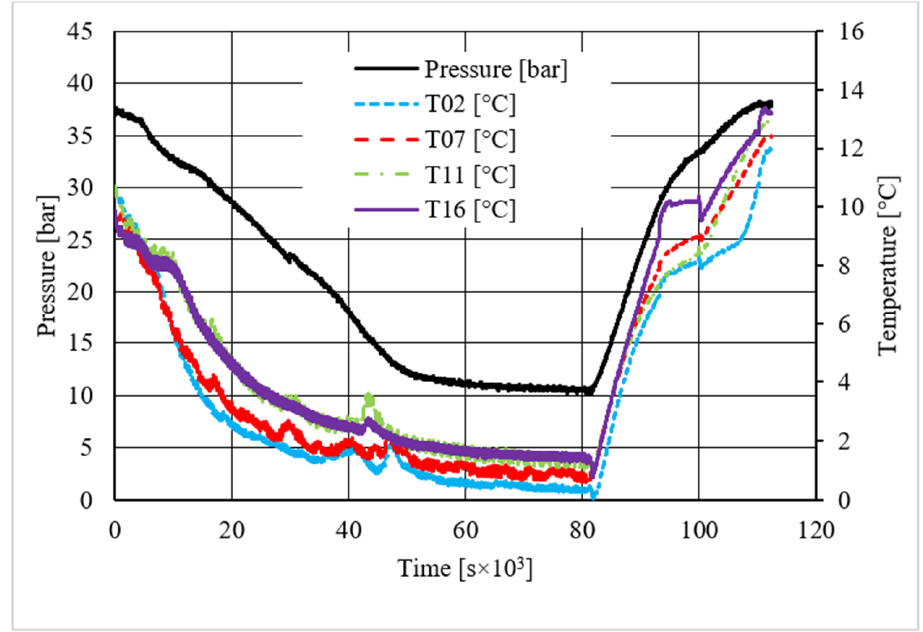
Figure 18. Pressure and temperature trend over time, measured for carbon dioxide hydrate formation in the presence of 18.01 wt.% CuSn12 powder.